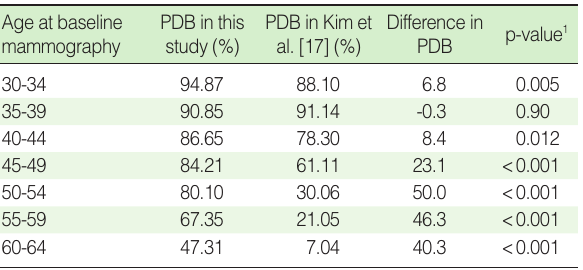
Table 2. Comparison of the proportion of dense breasts (PDB): snap- shot by age at the time of study of two separate study groups sepa- rated by a ten-year interval Age at baseline